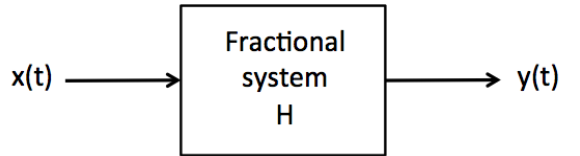
Figure 1. Fractional system representation in the